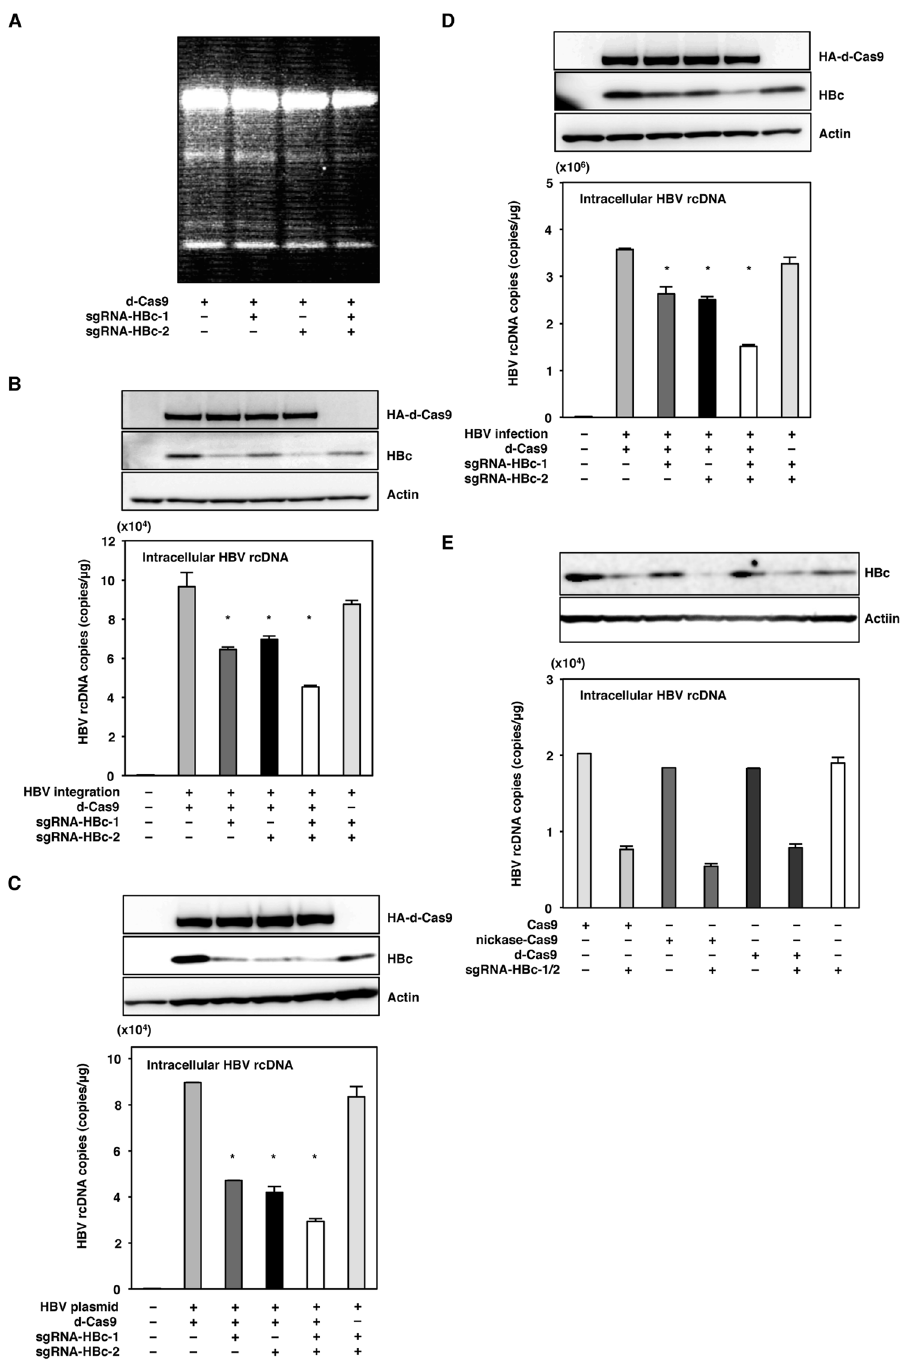
Figure 4. The binding of the Cas9 complex to the HBV genome suppressed HBV infection. ( A ) d-Cas9 with sgRNA-HBc-1 and/or sgRNA-HBc2 were lentivirally transduced in HepG2.2.15.7 cells. Total DNA was collected at 5 days post-transduction, and mutations of the HBV genome in HepG2.2.15.7 cells were detected by surveyor assay. ( B ) HepG2.2.15.7 cells transduced with d-Cas9 and the sgRNAs were collected at 5 days post-transduction, and the expression of HBc was determined by immunoblotting. Intracellular HBV rcDNAs were extracted at 5 days post-transduction and quantified by qPCR. ( C ) Huh7 cells transduced with d-Cas9 and the sgRNAs were transfected with a plasmid containing 1.3-fold-overlength genome of HBV at 3 days post-transduction. Cell lysates were collected at 3 days post-transfection, and the expression of HBc was determined by immunoblotting. Intracellular HBV rcDNAs were extracted at 3 days post-transfection and quantified by qPCR. ( D ) Nuclease dead Cas9 with the sgRNAs was lentivirally expressed in Huh7 cells. The plasmid containing 1.3-fold-overlength genome of HBV was transfected at 3 days post-transfection. Cell lysates were collected at 3 days post-transfection, and the intracellular HBc protein levels were determined by an immunoblotting analysis. Intracellular HBV rcDNAs were extracted at 3 days post-transfection and quantified by qPCR. ( D ) HepG2-hNTCP-C4 cells expressing d-Cas9 and the sgRNAs by lentivirus vector were